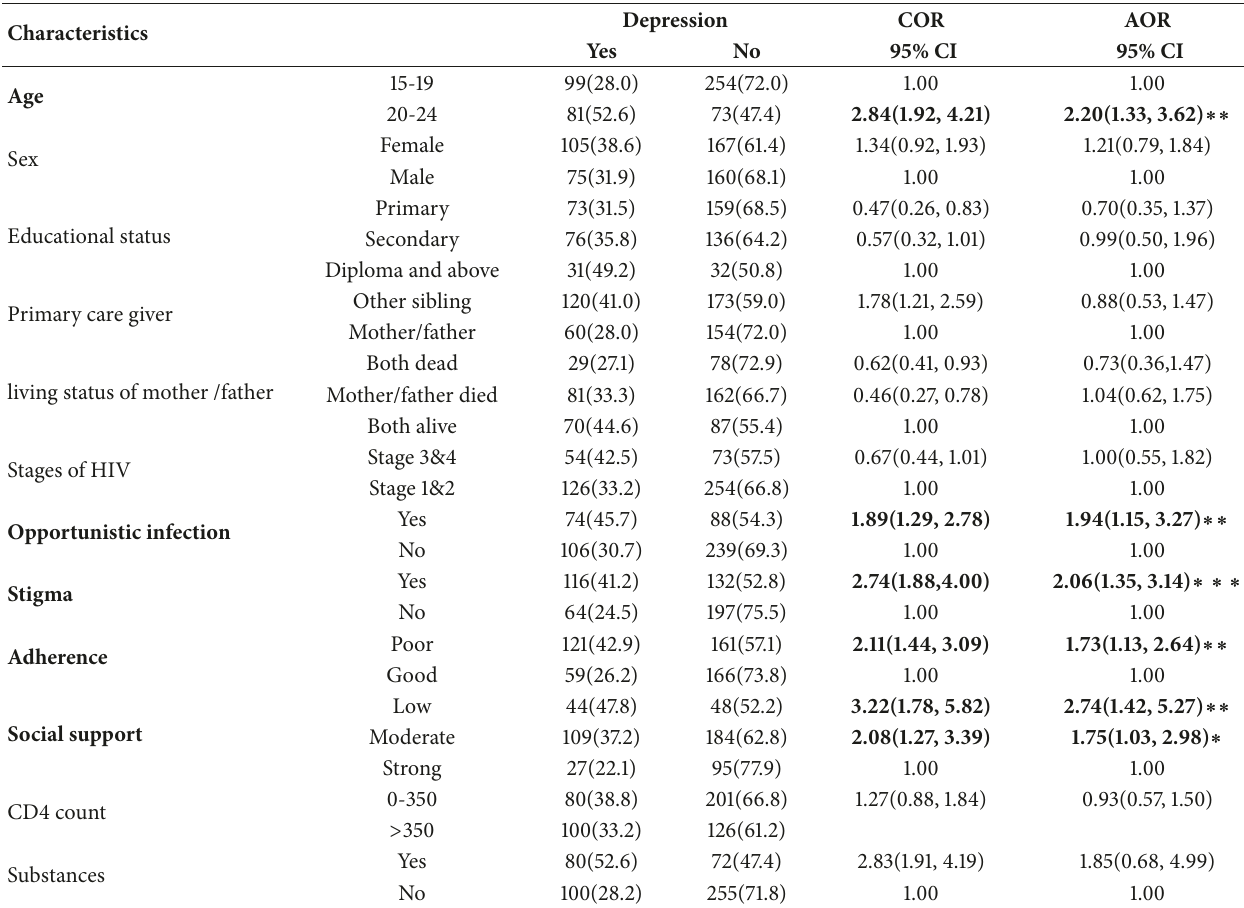
Table 3: Factors associated with depression among HIV positive youth attending ART follow-up at public hospitals in Addis Ababa, Ethiopia, 2016 (n=